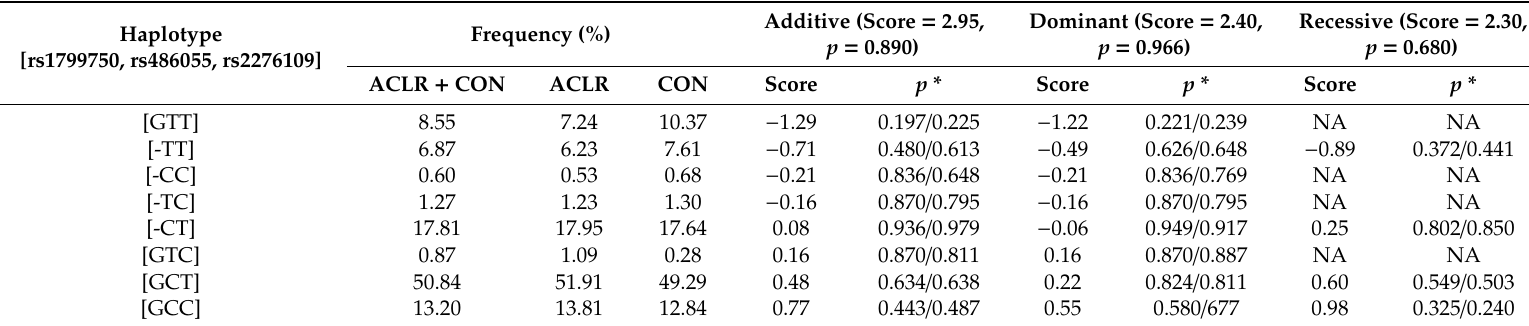
Table 6. Haplotype-based association of MMP1 , MMP10 and MMP12 polymorphisms (rs1799750, rs486055, rs2276109) with non-contact ACL